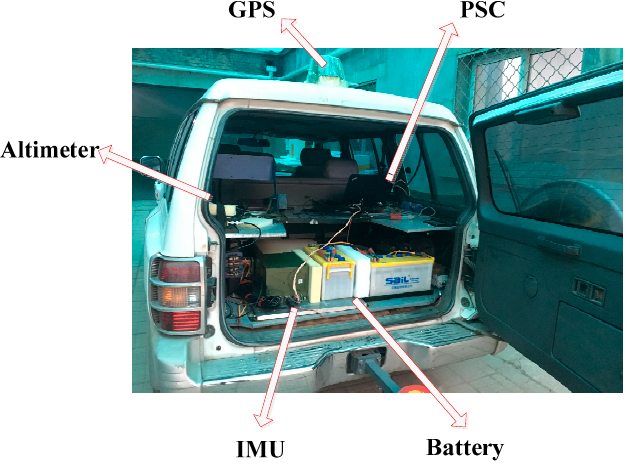
Figure 8. Field test device. PSC, processing computer system. Table 4. Performance of the sensors for the